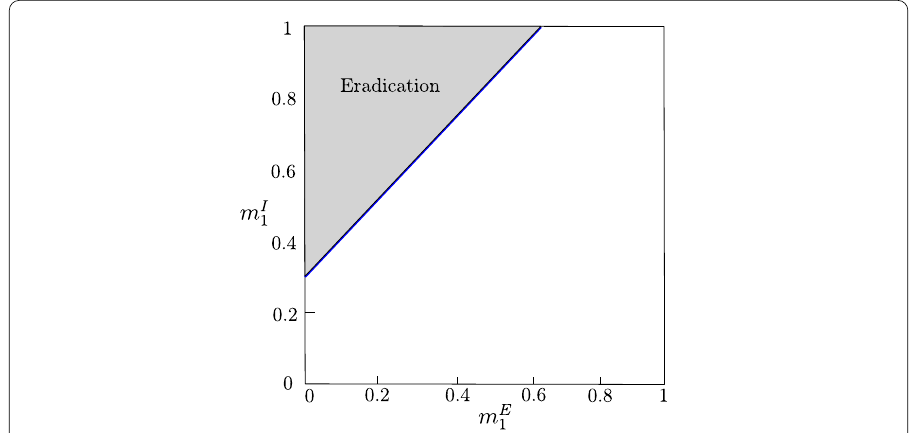
Figure 4 Let us consider system (15) with n = 2 and the following local parameters values: σ E j = 0.8, γ E j = 0.5 and β j = 0.75, j ∈ { 1,2 } , so A = 0.5; σ I 1 = 0.85, σ I 2 = 0.75, γ I 1 = 0.3, and γ I 2 = 0.15. The shaded triangle contains the values of m E 1 and m I 1 , stable equilibrium proportions of exposed and infectious individuals in patch 1, that ensure R 0 < 1 in system (21) and, therefore, the disease eradication in system (15). The blue line corresponds to R 0 =